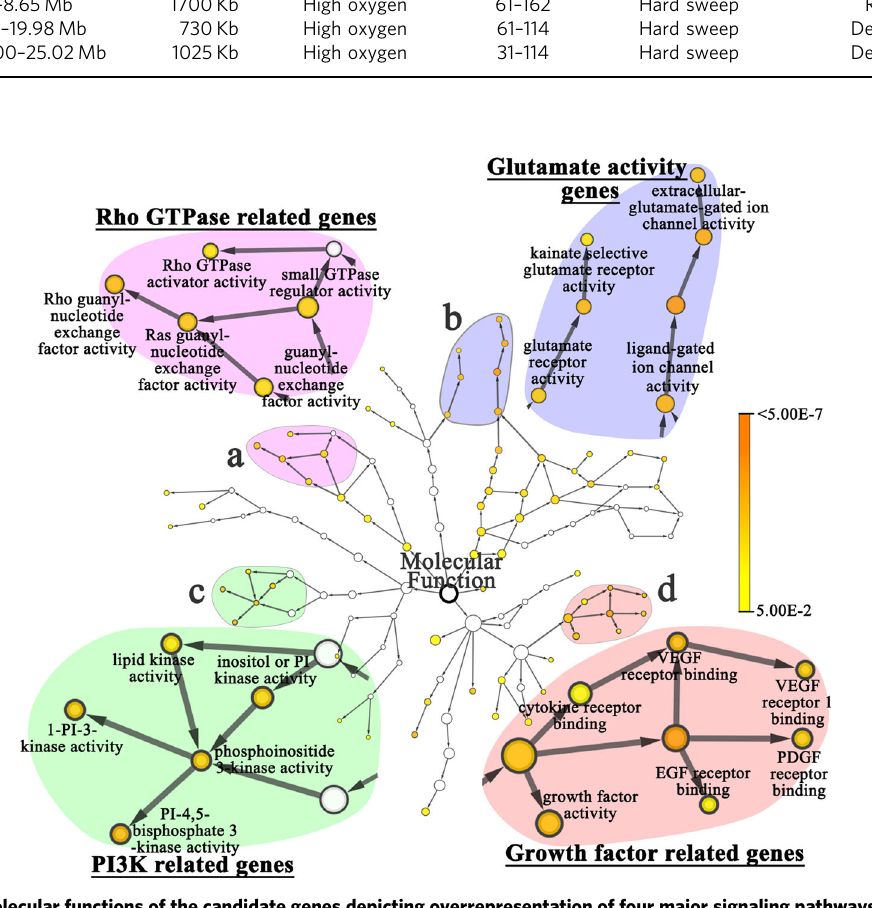
Fig. 4 Representative molecular functions of the candidate genes depicting overrepresentation of four major signaling pathways critical for regulating hypoxia tolerance. a Rho guanyl-nucleotide exchange factor activity (pink area, p -value = 5.65E-06), b glutamate receptor activity (purple area, p -value = 2.31-06), c PI3K activity (green area, p -value = 2.24E-06) and d Vascular endothelial growth factor (VEGF) signaling (orange area, p -value = 4.45E-06). The p -value was calculated using Hypergeometric test and corrected using Benjamini & Hochberg False Discovery Rate (FDR). A p -value < 0.05 as signi fi cant